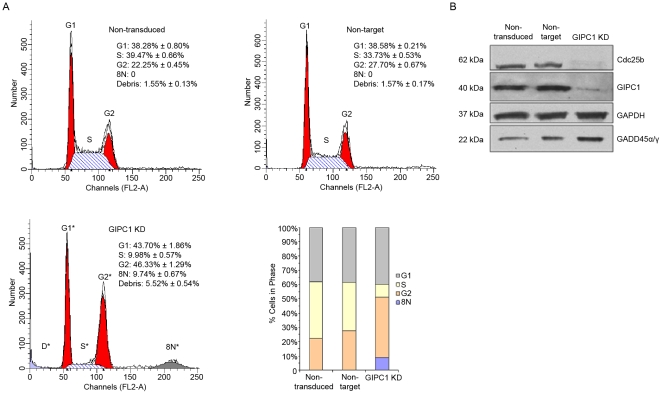
Single channel FACS analysis of GIPC1 KD MDA-MB231 human breast cancer cells.A. Single channel FACS analysis of non-transduced, non-target, and GIPC1 KD cells 14 days post-transduction. Grey is % cells in G1. Yellow indicates % cells in S phase. Orange equals % cells in G2. Blue is % cells at 8N. D indicates % debris. B. Western blot analysis of Cdc25b, GIPC1, and GADD 45 α/γ expression in non-transduced, non-target, and GIPC1 KD cells. Data are presented as means ± SEM. Asterisks indicate statistical significance (P≤0.05) between non-target and GIPC1 KD conditions.